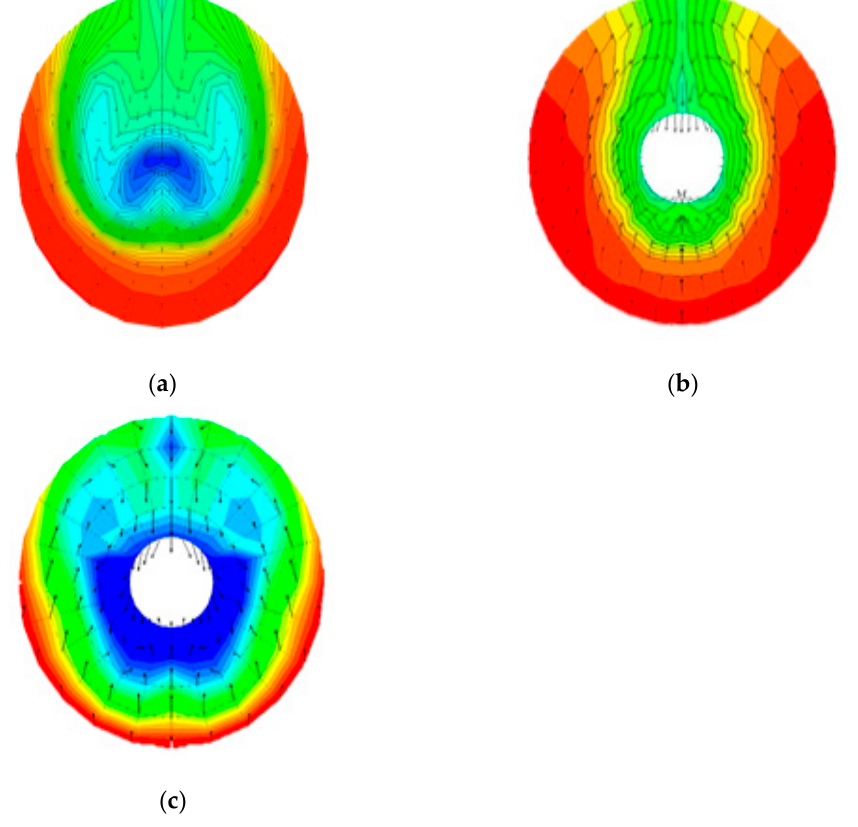
Figure 8. Comparison of nominal wake by ship types in EFD: ( a ) 158 K crude oil tanker W n = 0.452; ( b ) KCS container ship W n = 0.261; ( c ) 176 K bulk carrier W n = 0.623 [25]. Table 4. Comparison of self-propulsion analysis results between bare hull and with PSD.